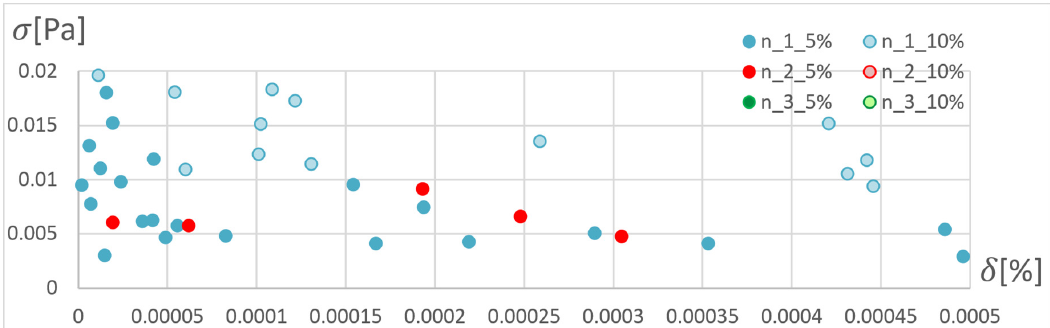
Figure 17. Pareto fronts representing the neural networks with the highest accuracy, trained using the RPROP algorithm.